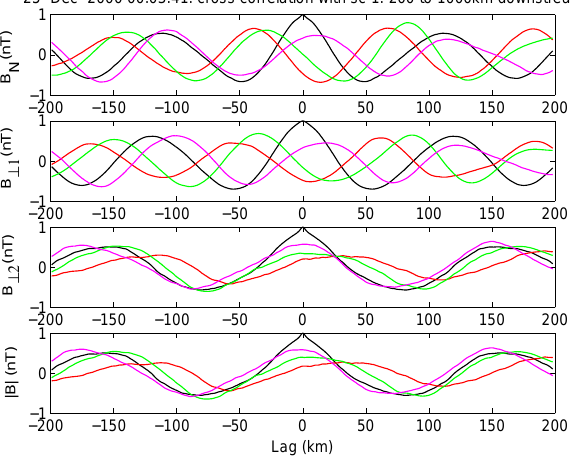
Fig. 4. High resolution magnetic field at all four Cluster spacecraft, during the quasi-perpendicular bowshock crossing shown in Fig. 3, plotted in terms of distance from the bowshock. Components are plotted in a coordinate system where B N is parallel to the shock normal, B ⊥ 1 is perpendicular to the normal and the upstream field direction, and B ⊥ 2 completes the right-handed set.